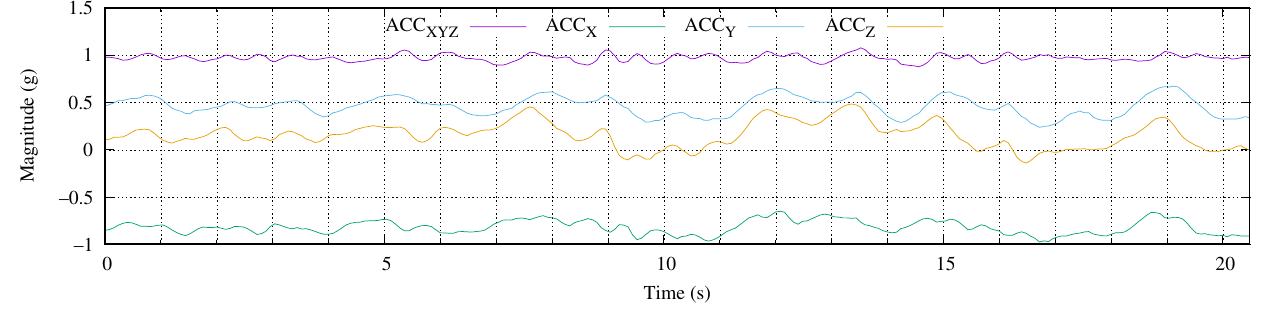
Figure 8. The raw data of the 256 acceleration measurements that were captured at a rate of 12.5 samples per